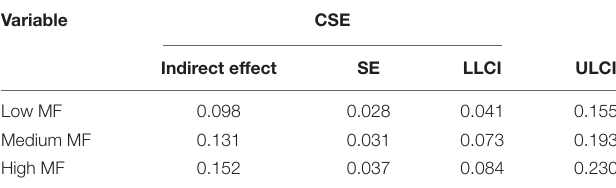
TABLE 5 | Results of the moderated mediation